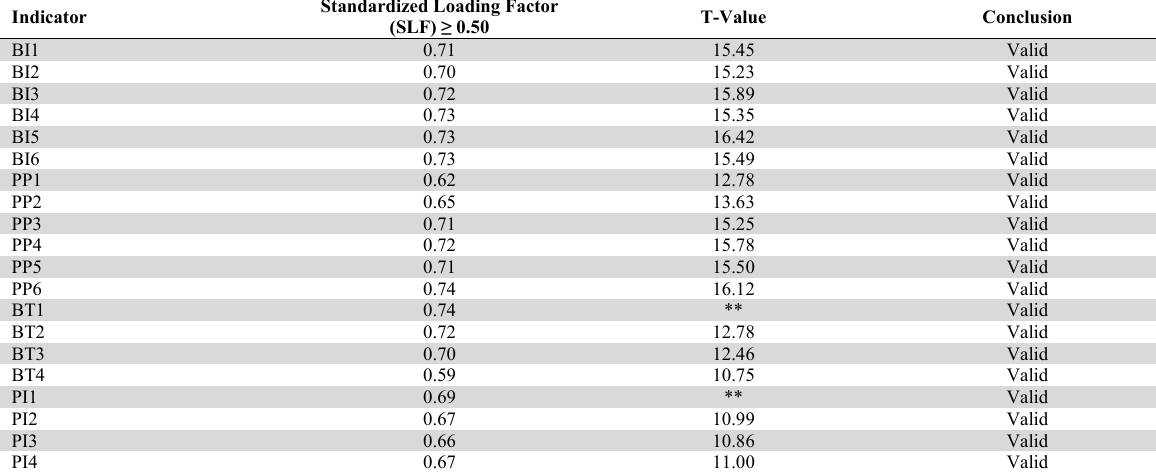
Standard Factor Loadings Indicator